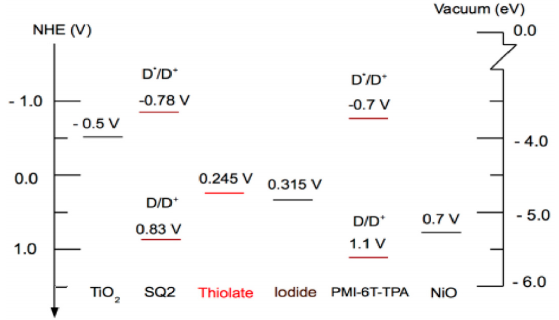
Figure 9. Potential and energy diagram for the components used in a t ‐ DSC with TiO 2 photoanode and NiO photocathode sensitized respectively with SQ2 [13] and PMI ‐ 6T ‐ TPA. The rest potentials of iodide and thiolate based mediators are indicated. Adapted from reference [44].